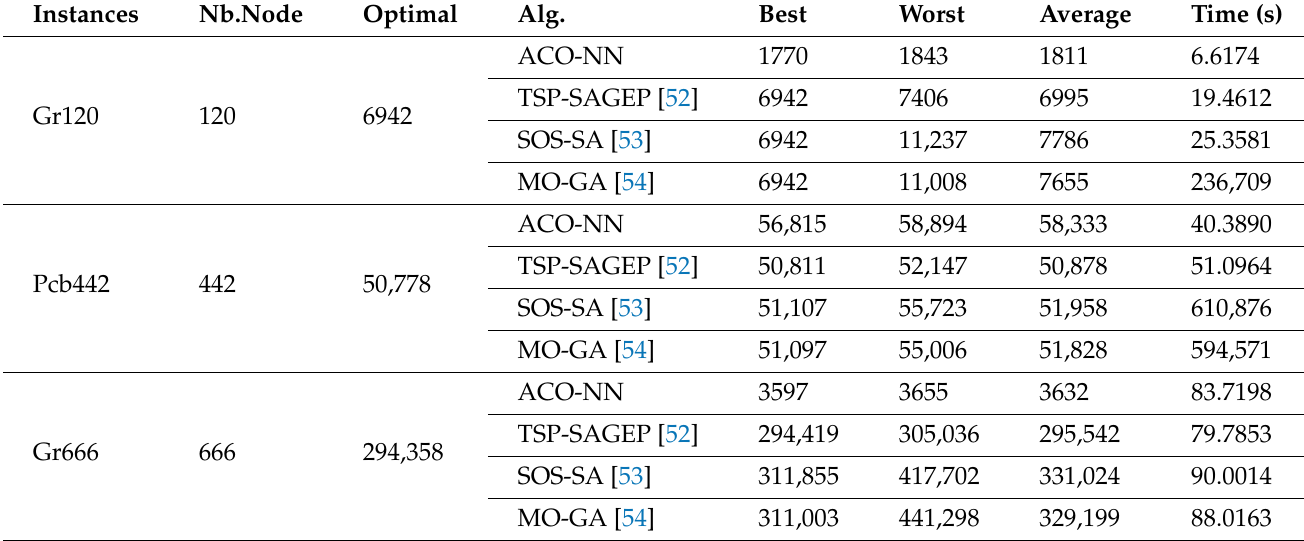
Table 9. Comparison of ACO-NN to various approaches for Gr120, Pcb442, and Gr666.